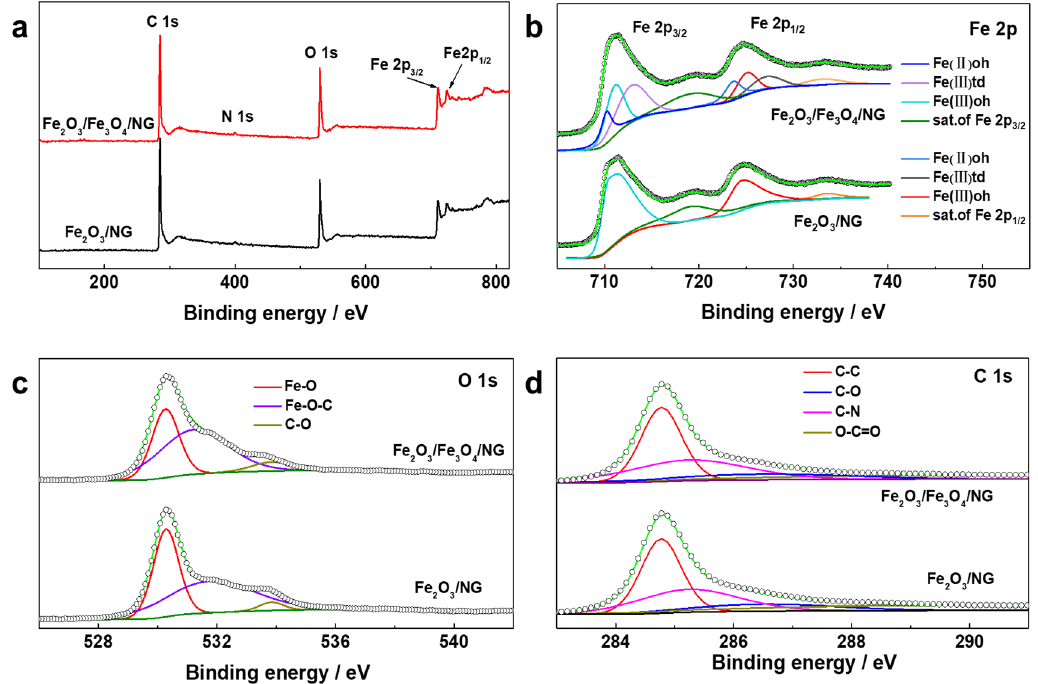
Figure 3. ( a ) XPS spectra of Fe 2 O 3 / Fe 3 O 4 / NG and Fe 2 O 3 / NG. The corresponding ( b ) Fe 2p spectra, ( c ) O 1s spectra, and ( d ) C 1s spectra.